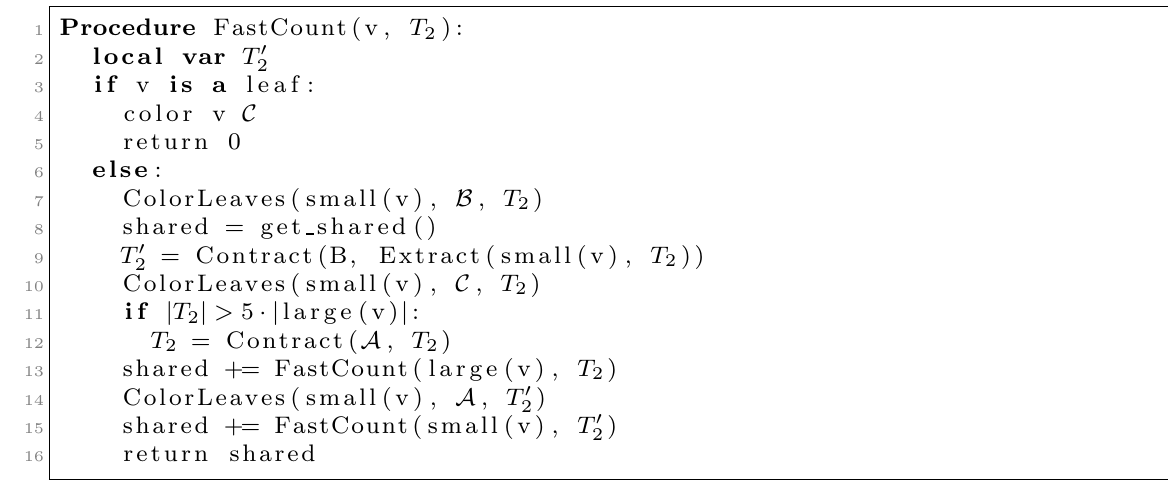
Figure 6. Tree coloring